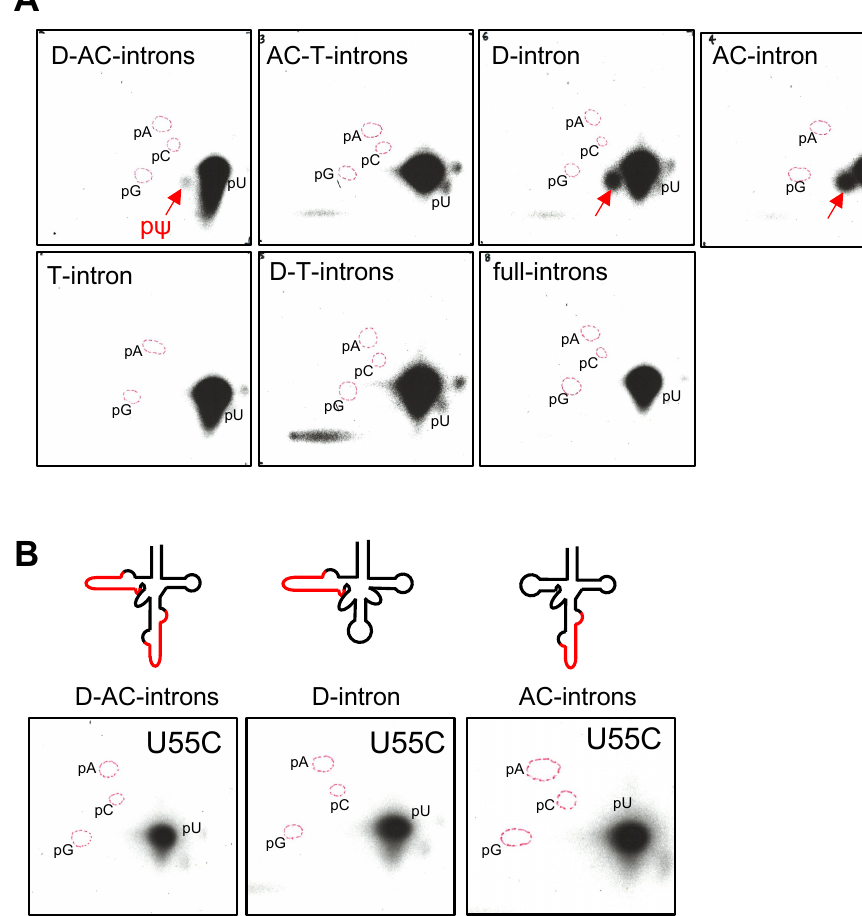
Figure 6. In vitro pseudouridylation activities of cmPus4 towards pre-tRNA Ile (UAU) and pre- tRNA Ile (UAU) mutants. Spots derived from p Ψ are indicated by red arrows. ( A ) The α - 32 P- UTP - labeled pre-tRNA Ile (UAU) transcripts were incubated with cmPus4, and the Ψ formation was analyzed by 2D-TLC. A p Ψ spot was detected in pre-tRNA Ile (UAU) containing D-AC-, D-, or AC-intron. ( B ) For the U55C mutant of pre-tRNA Ile (UAU) containing D-AC-, D-, or AC-intron, Ψ formation was analyzed by 2D-TLC. No Ψ spots appeared in any of the three